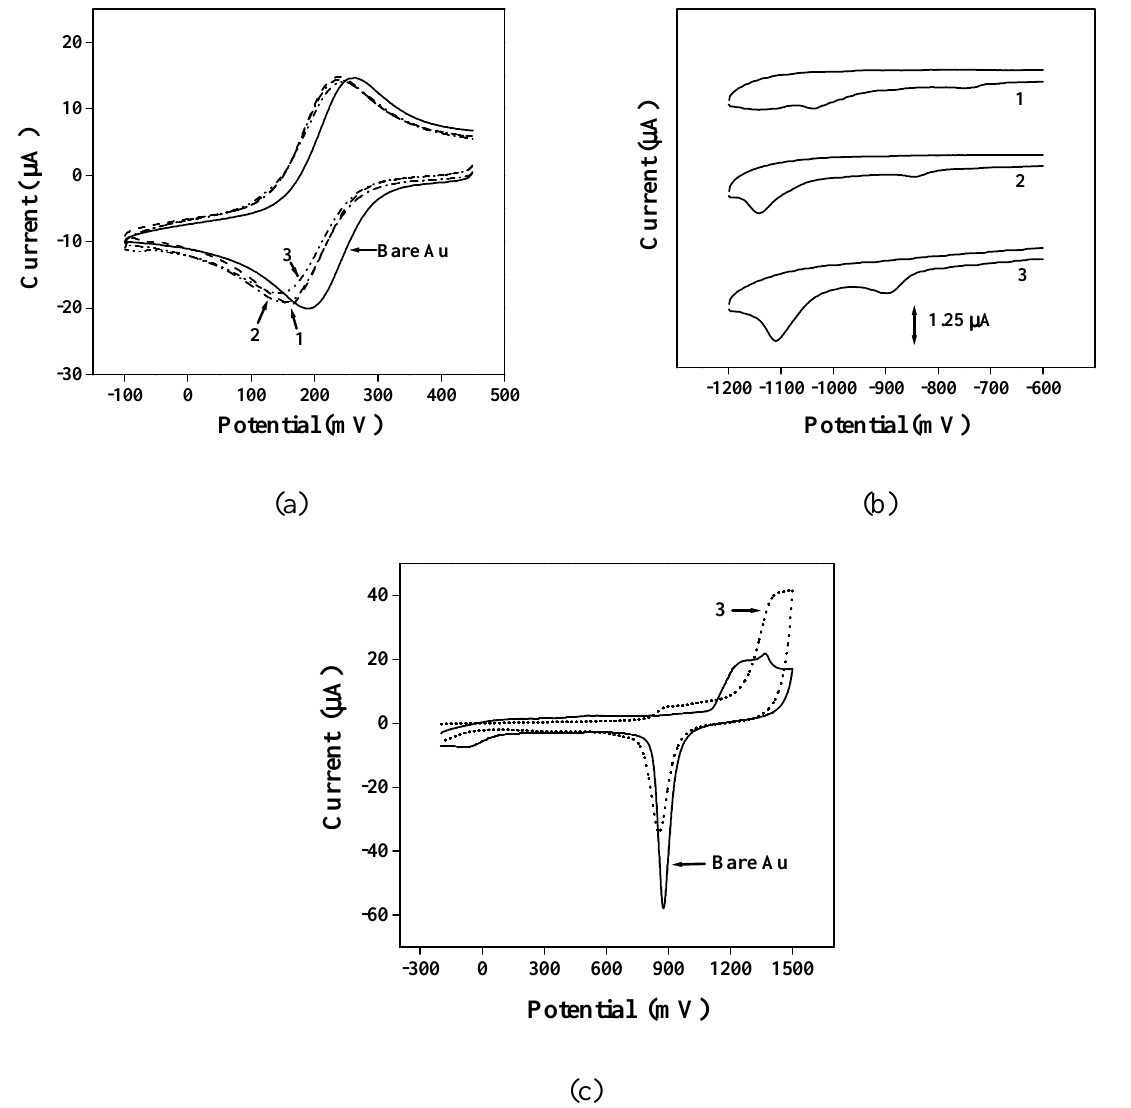
Figure 4 . CV of Bare and phenylboronic acids-modified Au electrodes immersed in (a) 0.1 M KCl with 1.0 mM [Fe(CN) ] 3- ; (b) in 0.5 M KOH and (c) in 0.5 M H 6